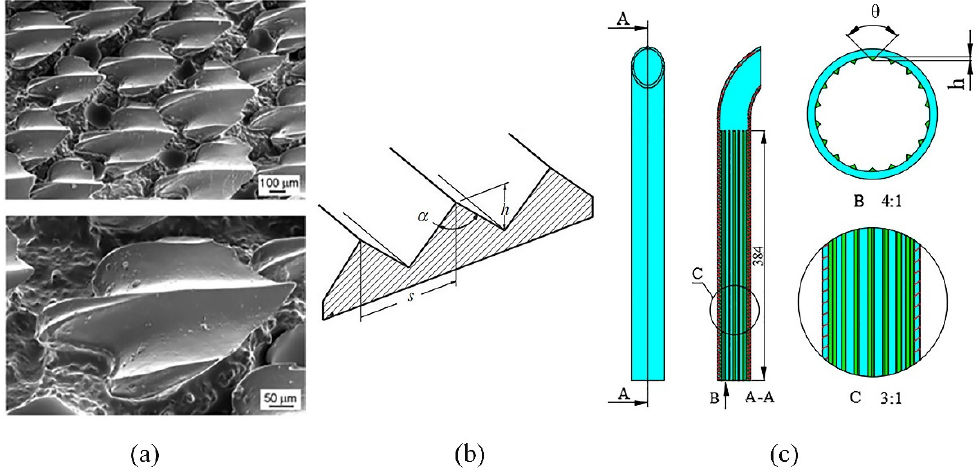
Figure 1. Bionic model diagram: ( a ) SEM micrographs of shark-skin ( Squalus acanthias ) replica [38], Reproduced with the permission of ref. [38], copyright@ J. Phys. Condens. Matter, 2010. ( b ) schematic of sawtooth riblets bioinspired by shark-skin surfaces [29], Reproduced with the permission of ref. [29], copyright@ Philos. T. R. Soc. A, 2010. ( c ) tractor bionic exhaust